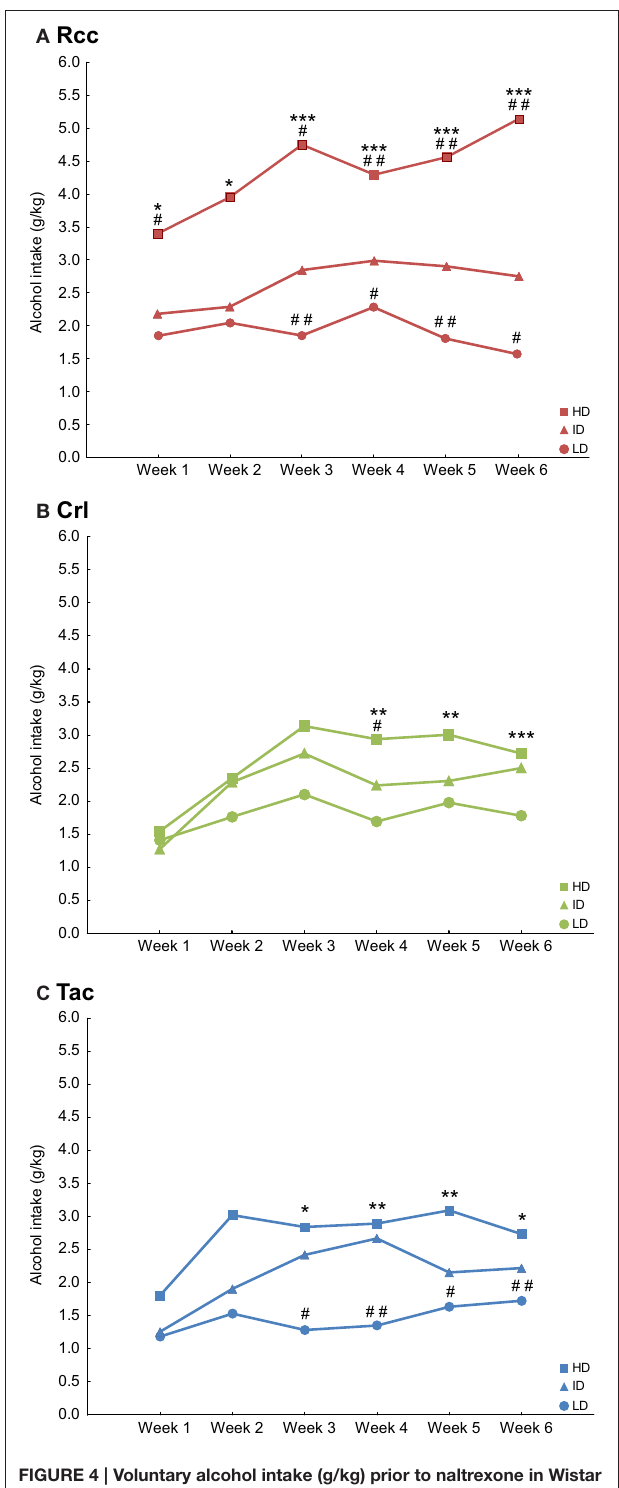
FIGURE 4 | Voluntary alcohol intake (g/kg) prior to naltrexone in Wistar rats from three different suppliers, i.e., RccHan TM :WI (Rcc, A), Crl:WI (Crl, B), and HanTac:WH (Tac, C), divided by a tertiary split into high drinkers (HD), intermediate drinkers (ID) and low drinkers (LD) based on alcohol intake during weeks 1-6. Data are shown as median. * p ≤ 0.05 , ** p < 0.01 , *** p < 0.001 compared to the respective LD group; # p ≤ 0.05 , ## p < 0.01 compared to the respective ID group (Mann-Whitney